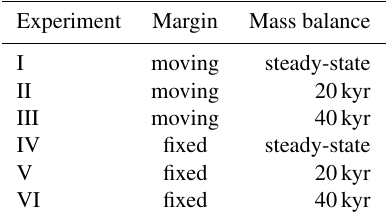
Table 2. The step-wise flow factor changes in the MISMIP experi-